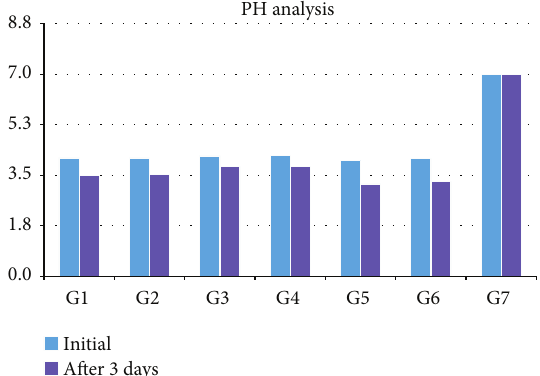
Figure 2: It shows the distribution of the pH values of fruit juice plus soy and the control group at baseline and after 3 days of use (groups: G1: AdeS Grape, G2: AdeS Apple, G3: Solly’s Grape, G4: Solly’s apple, G5: More Vita Grape, G6: More Vita apple, and G7: control). Red dashed line is the pH value for demineralization of the enamel surface (pH =